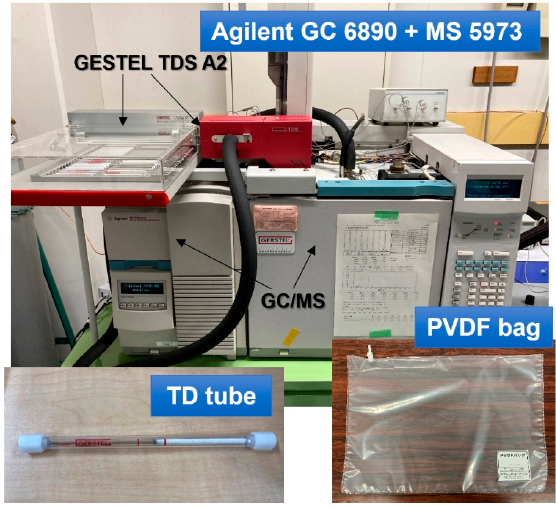
Figure 5. GC/MS system, TD tube, and PVDF bag. Table 2. Conditions of GC/MS.